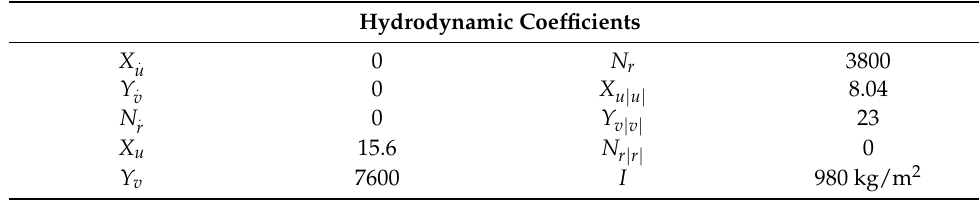
Table 4. Hydrodynamic coefficient and parameters.